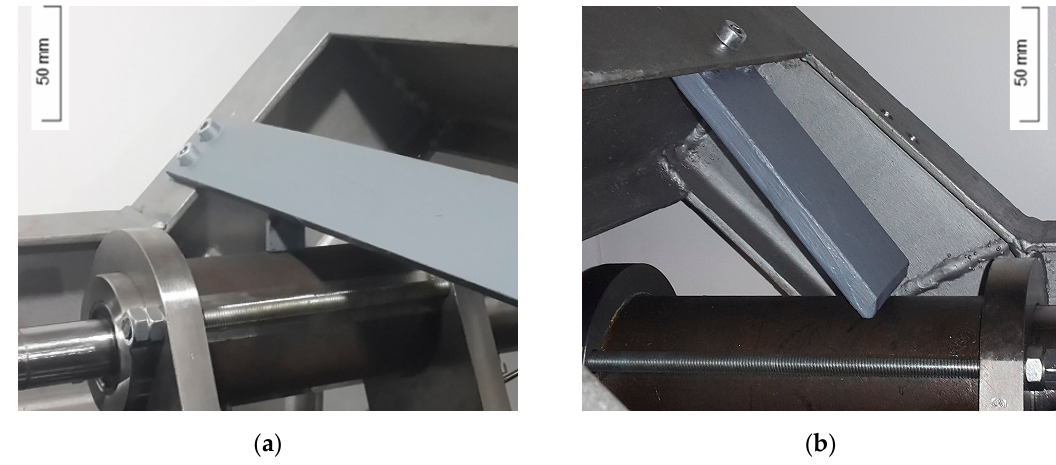
Figure 8. Adjustment stops for crossheads: ( a ) with load cell; ( b ) without load cell.